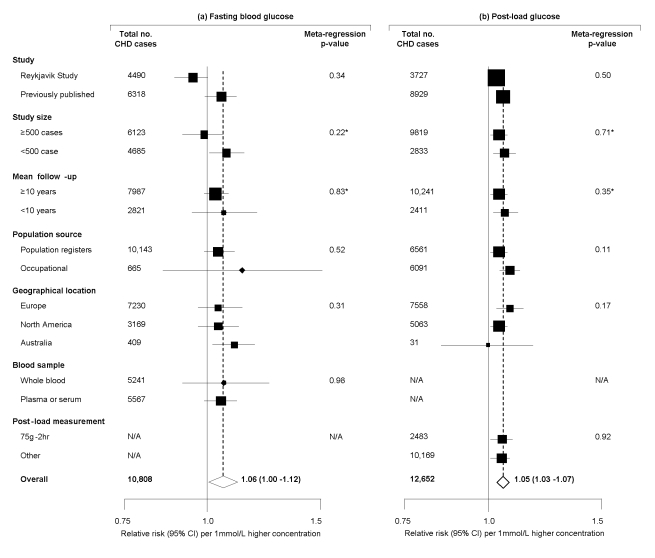
Prospective studies of fasting and post-load glucose and CHD risk in individuals without diabetes in Western population, grouped by study characteristics.Meta-regression analyses separately considered each characteristic presented. *Assessed as continuous factors.